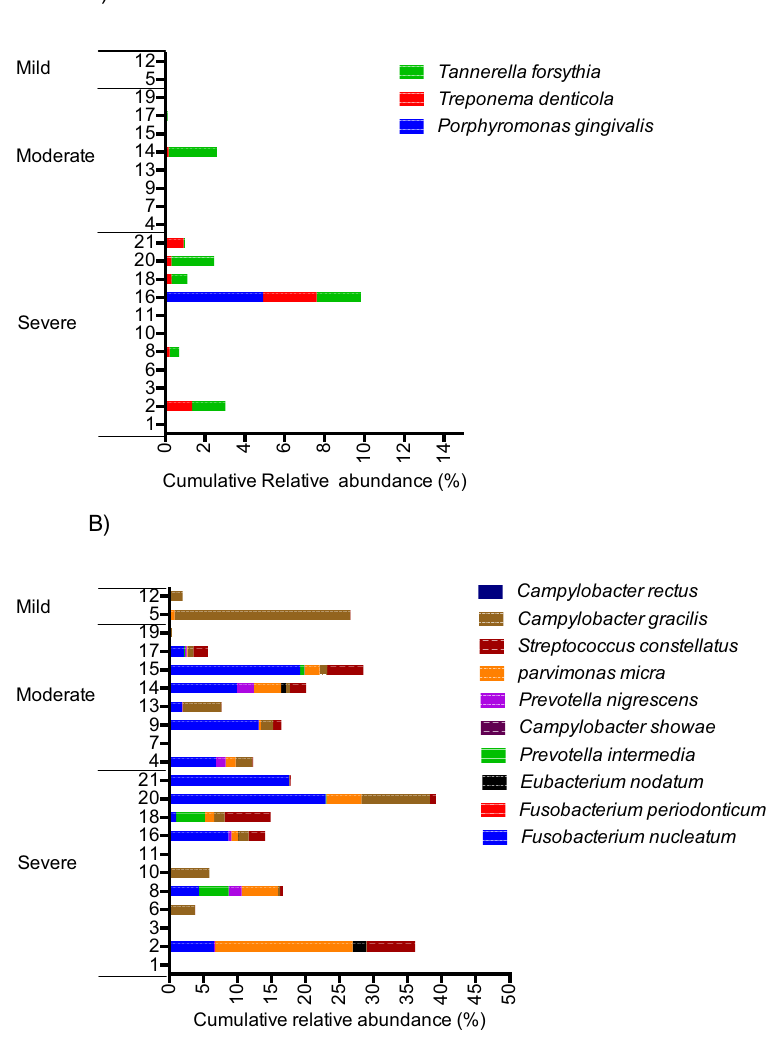
Figure 4. Cumulative abundance of species belonging to the red complex ( A ) and the orange complex ( B ) for each patient. Patients are ordered according to the severity of their periodontitis. The three subspecies of F . nucleatum included in the orange complex (subsp. nucleautm , subsp. polymorphum , subsp. vincentii ) are